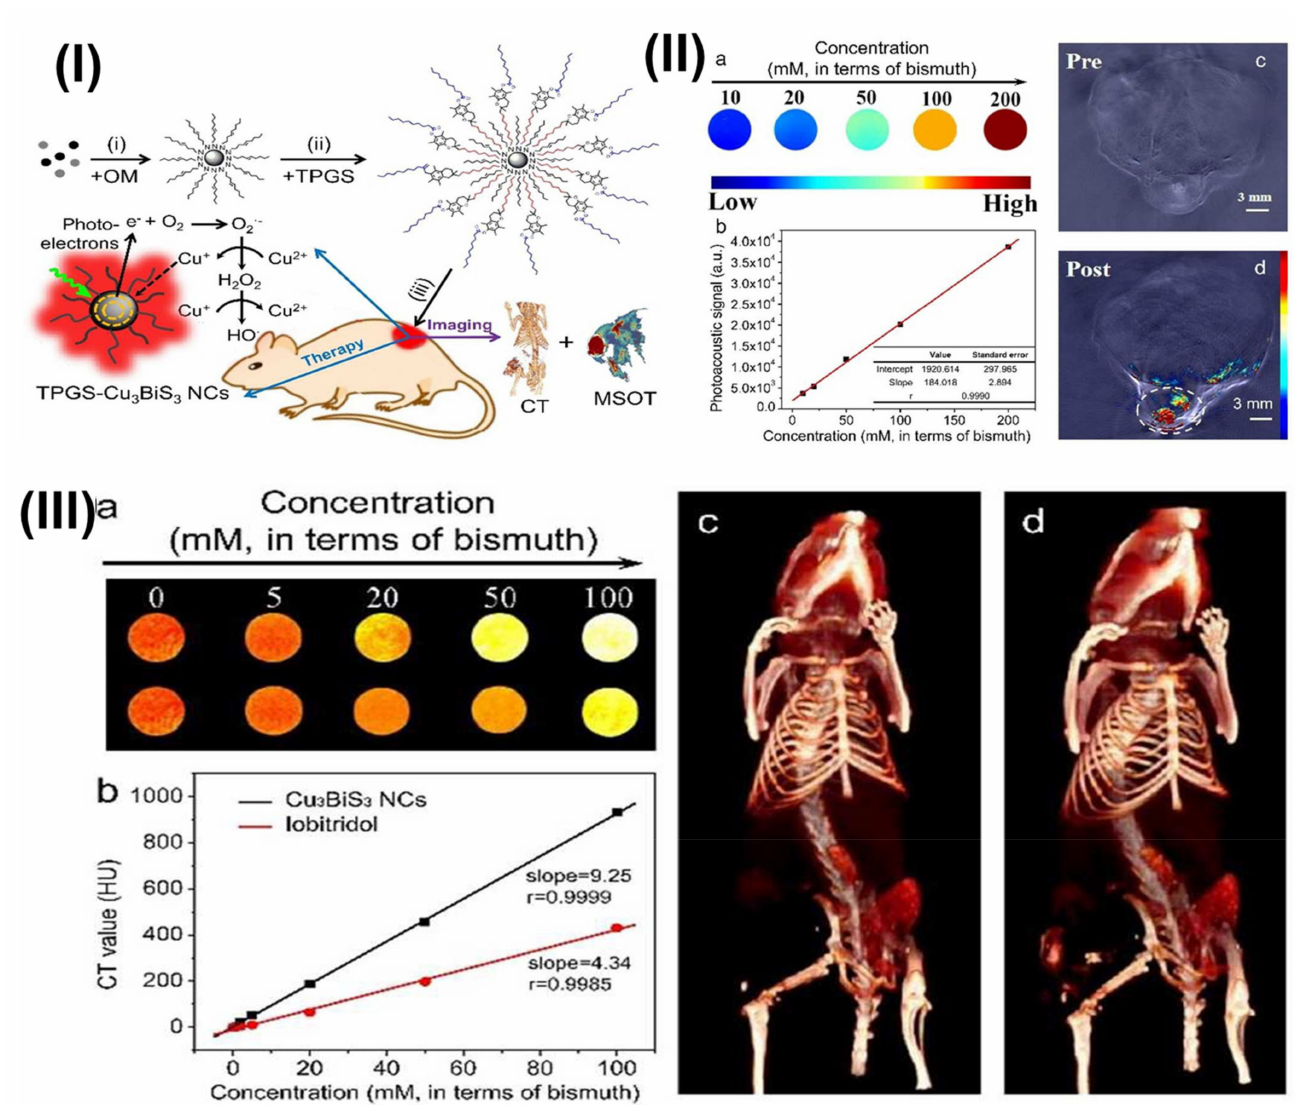
Figure 11. ( I ) Radiation therapy could be improved with the use of TPGS-functionalized Cu3BiS3 NCs, as shown in this schematic; ( II ) ( a ) Aqueous dispersion photos of TPGS-Cu3BiS3 NCs at various concentrations captured using a PA phantom; ( b ) Diagrams depicting the PA signal’s relationship to TPGS-Cu3BiS3 NC concentration; ( c , d ) In vivo PAT imaging of a tumor-bearing mouse before ( c ) and after ( d ) Injection with TPGS-Cu3BiS3 NCs; ( III ) ( a ) Cu3BiS3 NCs (upper) and iopromide (lower) CT phantom images at varying doses; ( b ) Diagram showing the relationship between TPGS-Cu3BiS3 NCs, iopromide HU values, and sample concentrations; ( c , d ) CT scans of mice taken prior to the injection of TPGS-Cu3BiS3 NCs; ( c ) and 3 h after intravenous injection of TPGS-Cu3BiS3 NCs ( d ). Reproduced with permission from Ref. [124], Scheme 1, Figures 6 and 7. (Royal Society of Chemistry ©